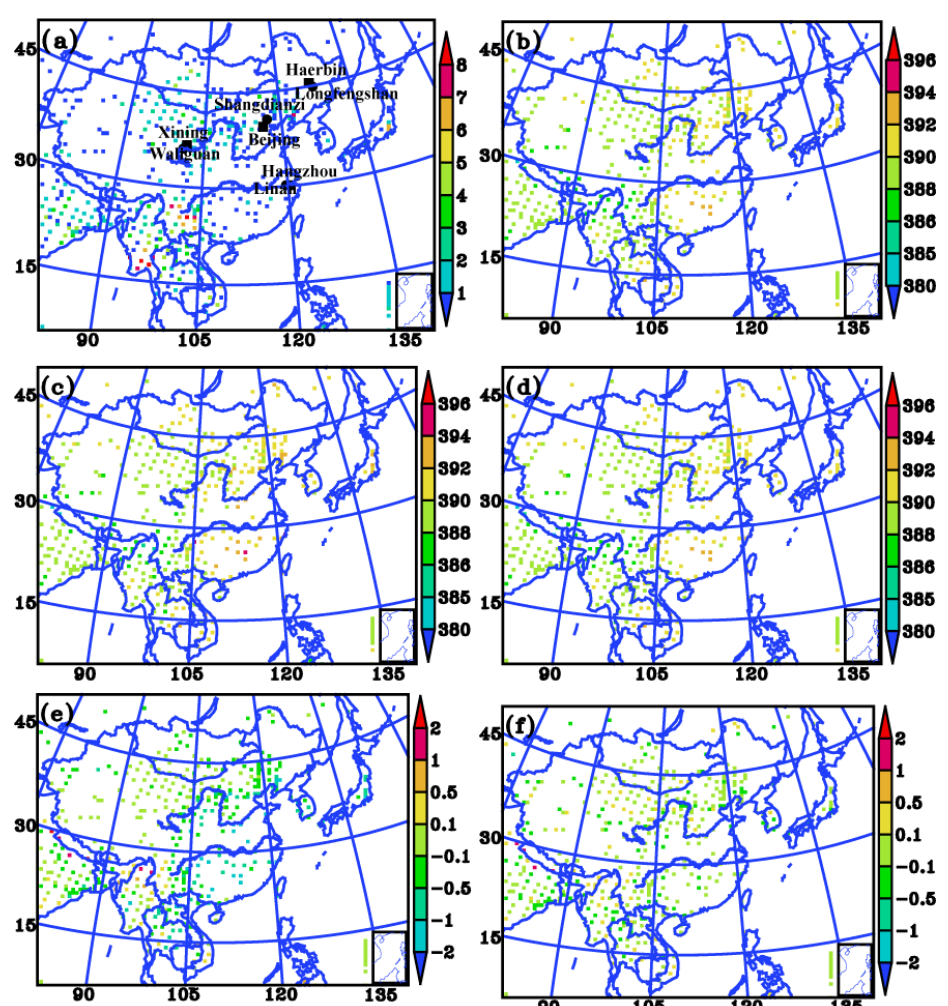
Figure 3. (a) Total number of observations in February 2010 in the model grid. Each symbol indicates the total number of all GOSAT X CO measurements in the corresponding model grid. Monthly mean values in February 2010 of (b) X p column mixing ratio of C f t ; (d) X a , column mixing ratio of C a t ; (e) X p CO 2 column-averaged with real GOSAT X CO averaging kernels at GOSAT X CO 2 all X CO estimates in the model grid. C a t are the ensemble mean values of the assimilated CO 2 concentrations fields of a CFI-CMAQ OSSE, 2 in which the lag-window was 9 days and β was 70. They are the same OSSE in Figs.